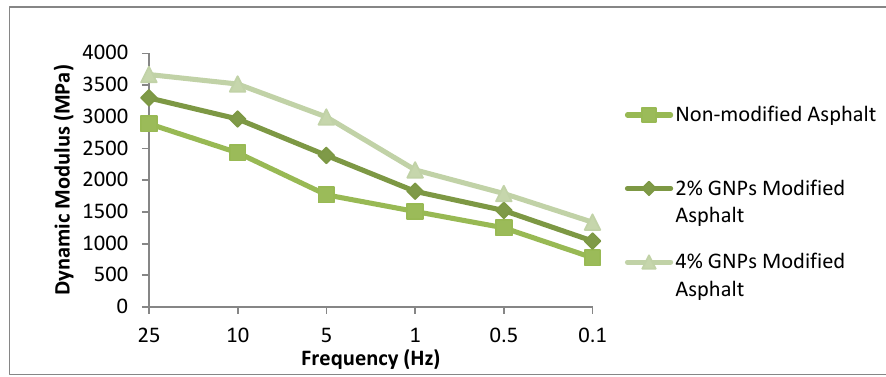
Figure 10. The Dynamic Modulus at 40 °C. GNPs = Graphene Nano-Platelets. Appl. Sci. 2019 , 9 , x FOR PEER REVIEW